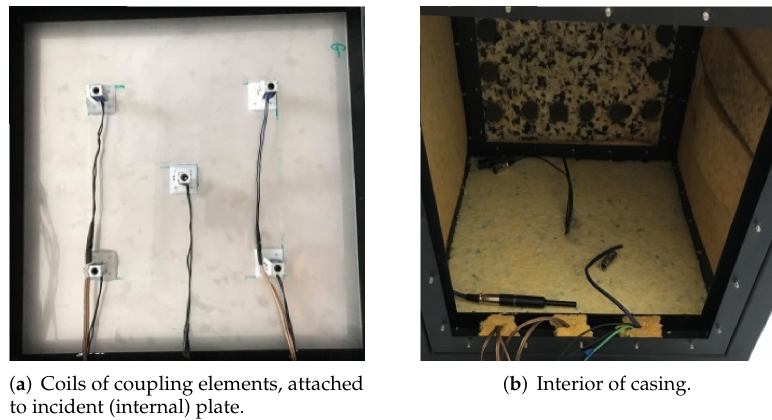
Figure 4. Investigated cubic casing with a rigid frame.